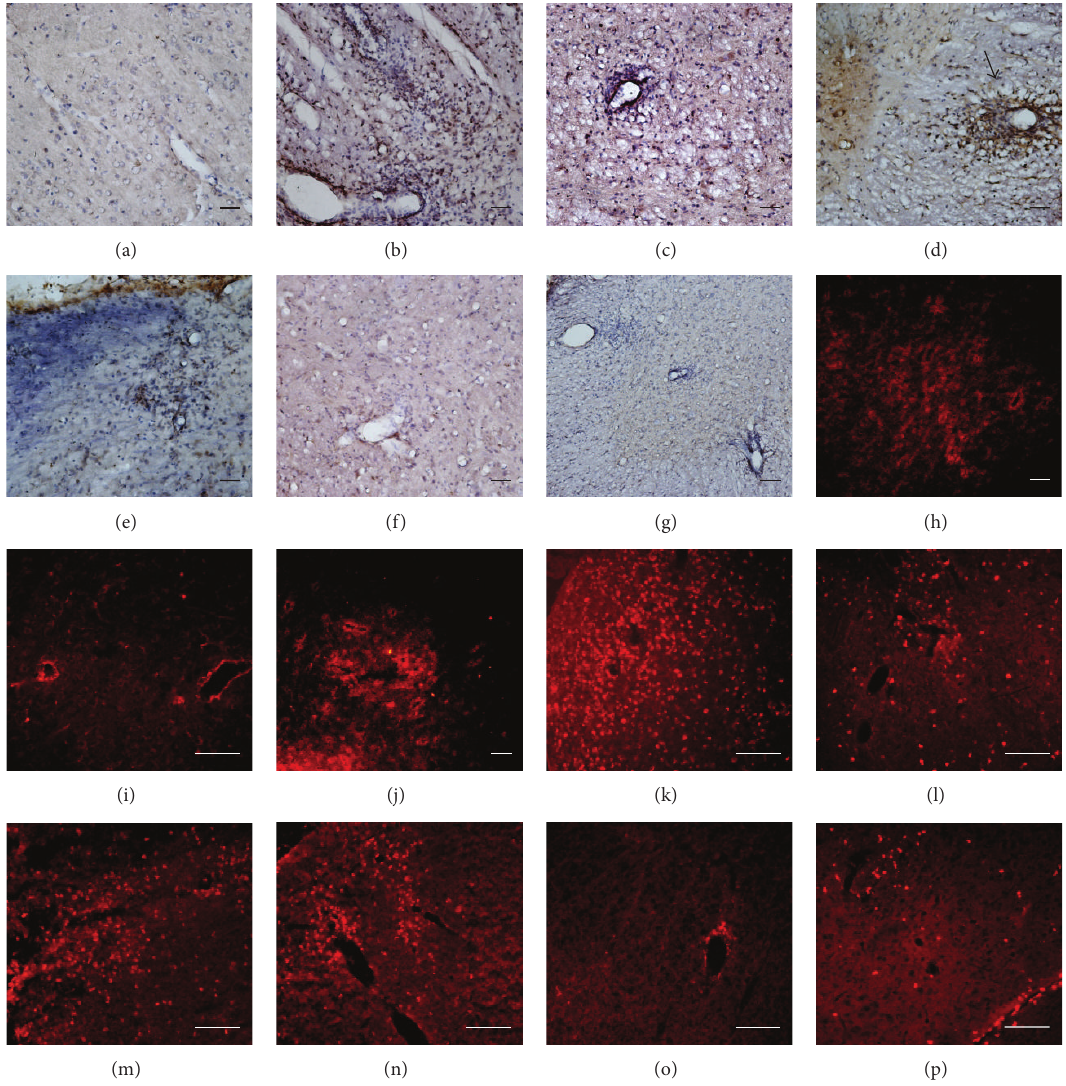
Figure 2: ((a)–(g)) C16 treatment attenuated the CD4 + lymphocytes extravasation in CNS both at weeks 2 and 8 after immunization. CD4 immunostaining, counterstained with hematoxylin; bar = 100 𝜇 m. At week 2 after immunization, normal group (a), vehicle control rats (b) (with severe cellular infiltration within parenchyma and surrounding blood vessel), 1mg /day C16 treated EAE rats (c), C16 late treated EAE rats (d) (the arrow denotes “perivascular cuffing” of CD4 + lymphocyte). At week 8 after immunization, vehicle control rats (e), and 1mg/per day C16 treated EAE rats (f), and C16 late treated EAE rats (g). ((h)–(j)) The C16 treatment attenuated the leukocytes infiltration in CNS both at weeks 2 and 8 after immunization. TRITC conjugated CD45 immunofluorescent staining. At week 2 after immunization, vehicle control rats (h), 2 mg/per day C16 treated EAE rats (i), and C16 late treated EAE rats (j). ((k)–(p)) The C16 treatment attenuated macrophages extravasation in CNS both at weeks 2 and 8 after immunization. TRITC conjugated CD68 immunofluorescent staining. At week 2 after immunization, vehicle control rats (k), 2 mg/per day C16 treated EAE rats (l), and C16 late treated EAE rats (m). At week 8